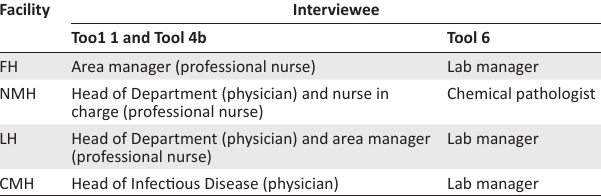
TABLE 1: Interviewee role identification.